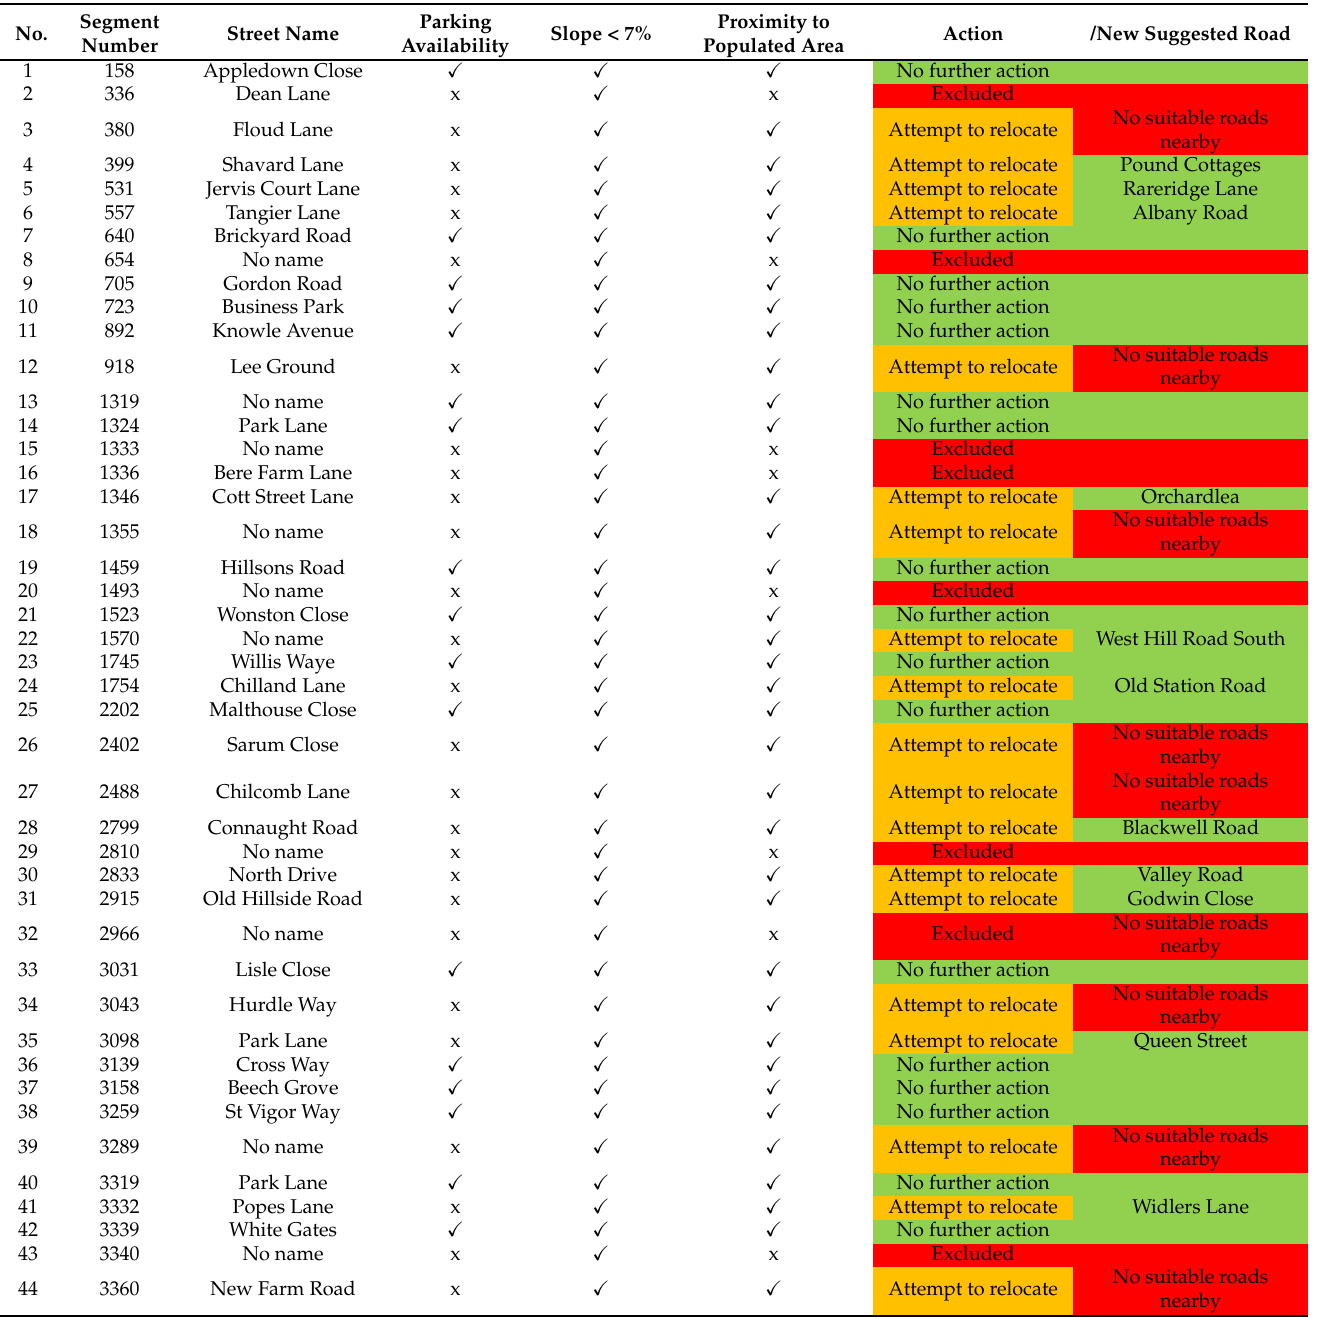
Table 4. Optimal on-road EV charging points process. Green: No further action; Orange: Attempt to relocate; Red: